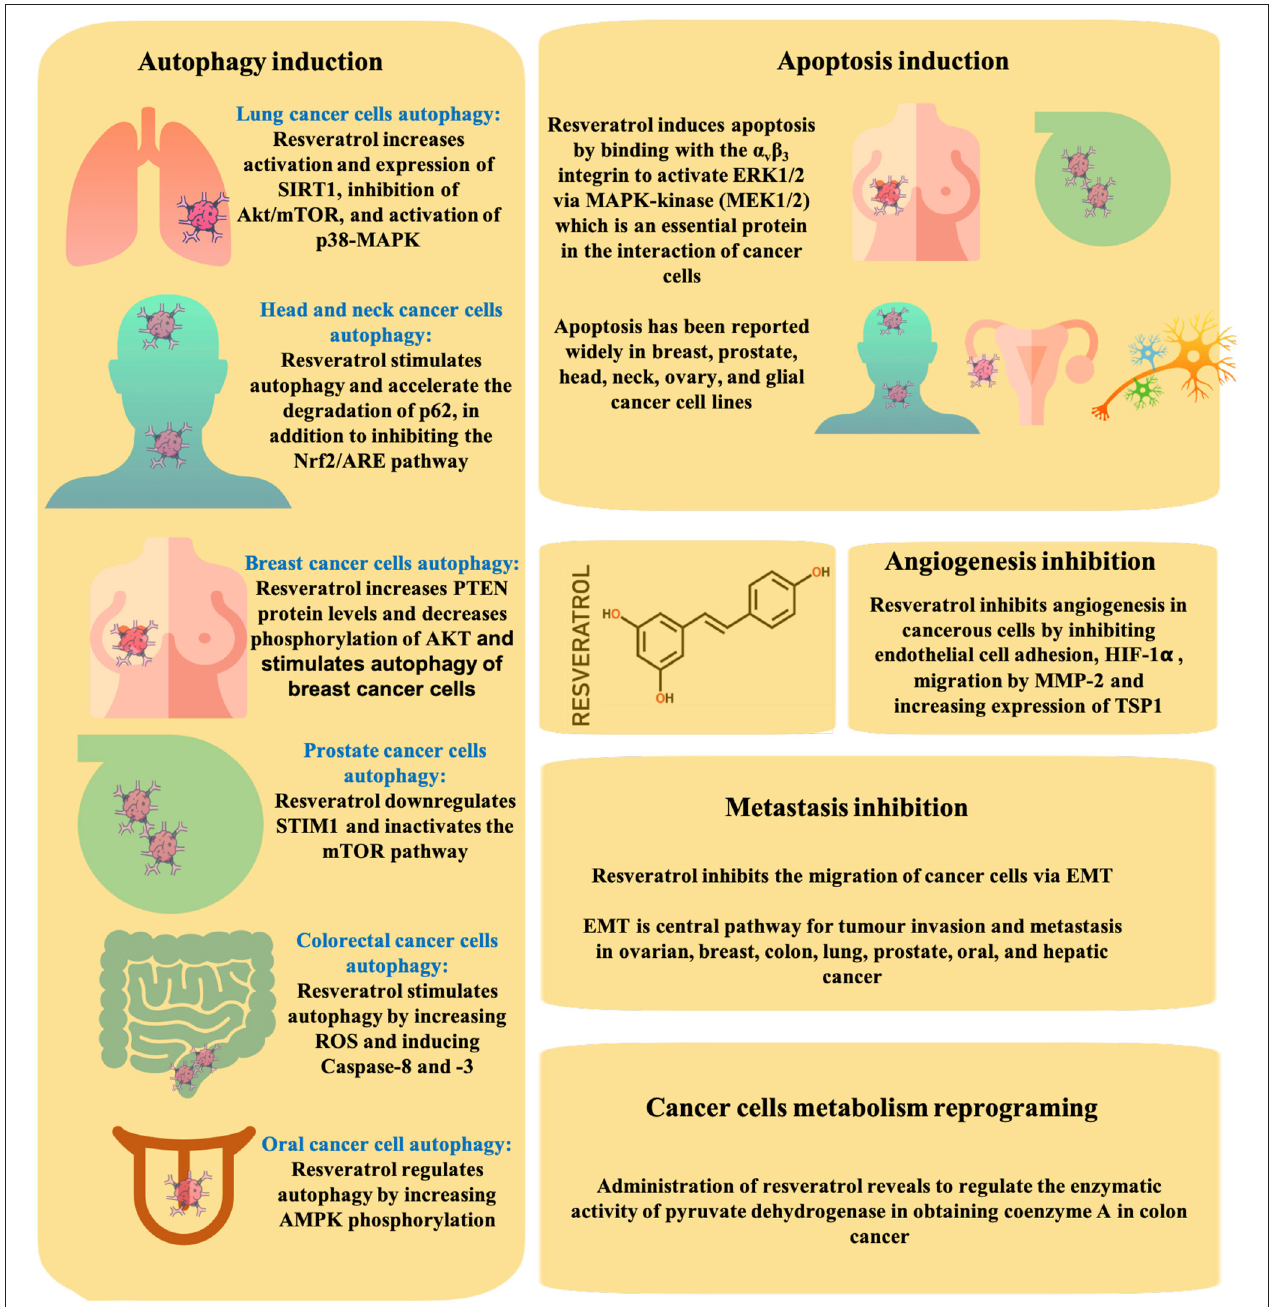
FIGURE 2 | Dominant pathways by which resveratrol inhibits cancer progression, including the induction of autophagy and apoptosis, inhibition of angiogenesis and metastasis, and reprogramming of the cellular metabolism.